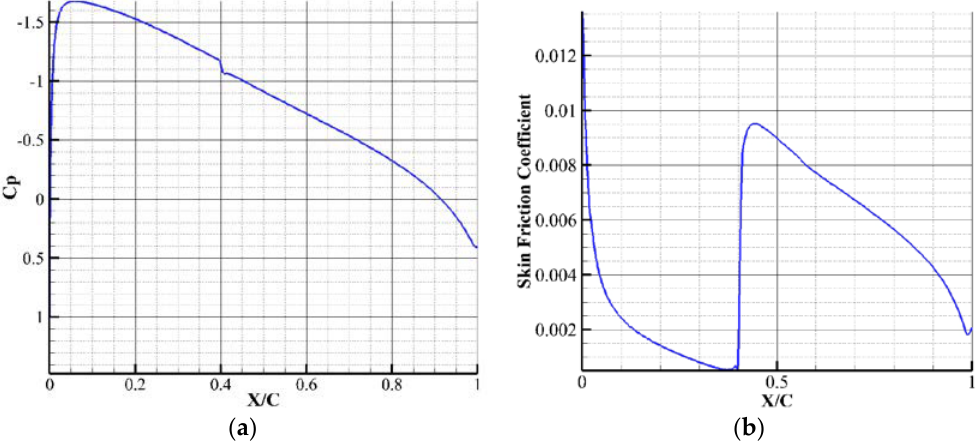
Figure 9. Changes in ( a ) the pressure coefficient value and ( b ) the skin friction coefficient values at X/C = 0.41 for a clean NACA 2412 airfoil ( Re = 5.9 × 10 6 and α = 2.5°). These abrupt changes in the pressure and skin friction coefficient values were not observed